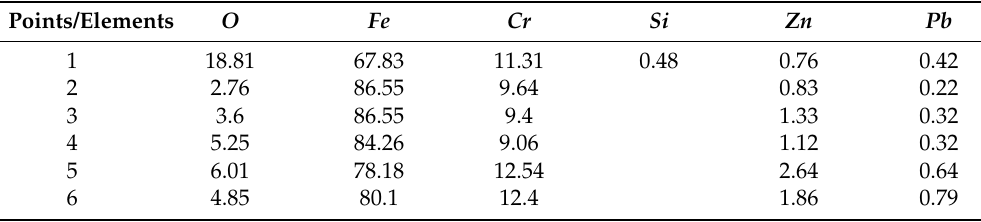
Table 6. Spot analyses (positioned in Figure 10b), wt.